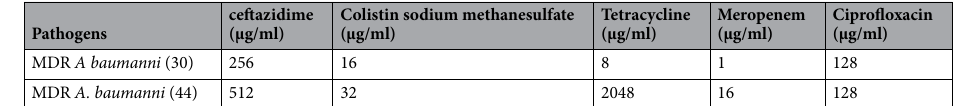
ceftazidime (µg/ml)